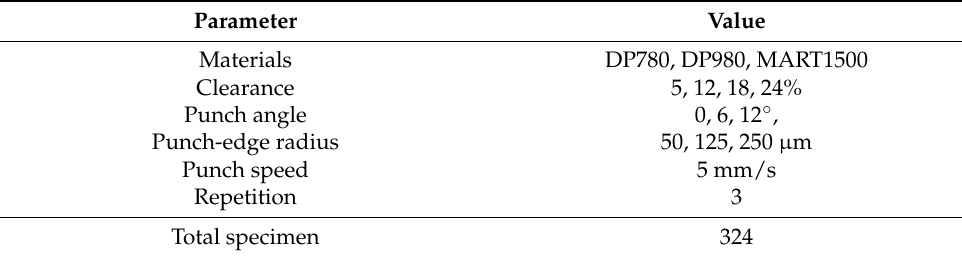
Table 3. Experimental conditions for punching.